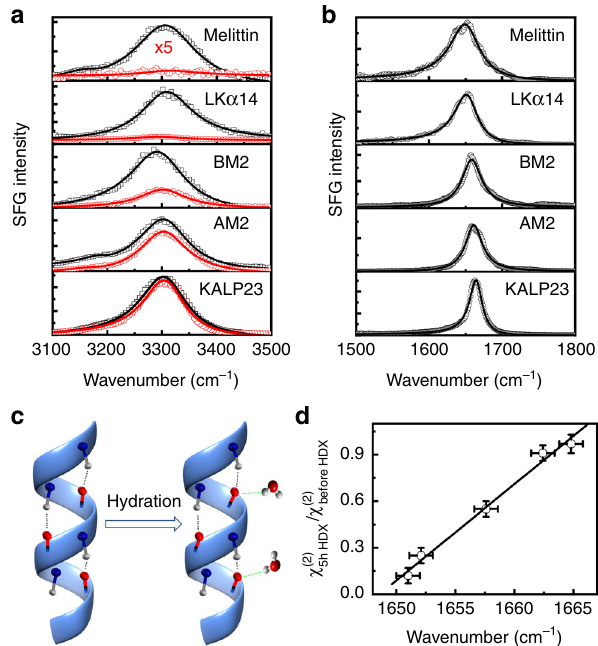
Fig. 1 Sum frequency generation (SFG) spectra. The ssp (denoting s-, s-, and p-polarized sum-frequency output, visible input, and infrared input, respectively) SFG spectra of the peptides of amide A and amide I modes, sketch for the hydration of amide I mode, and the relationship between hydrogen – deuterium exchange (HDX) ratio and amide I frequency. a The ssp SFG spectra of the peptides in the N-H region. The spectra in black curves are measured at lipid bilayer/H 2 O interface while the ones in red curves are measured at lipid bilayer/D 2 O interface after 5-h HDX experiments. b The ssp amide I SFG spectra of peptides at lipid/H 2 O interface. The solid curves in a , b are the fi tting curves using Supplementary Eq. 1. c Sketch for the carbonyl groups forming a bifurcated H bonding to water molecules upon hydration. d Fitting amplitude ratio (cid:1) χ ð 2 Þ = χ ð 2 Þ of the ssp SFG spectra in the N-H region after 5-h 5hHDX beforeHDX HDX and before HDX against the amide I frequency. The vertical error bars represent experimental error in determining the amplitude ratio from the fi tting procedure (see Supplementary Note 2). The horizontal error bars indicate the standard error of the mean of the fi tting center frequency from fi ve independent